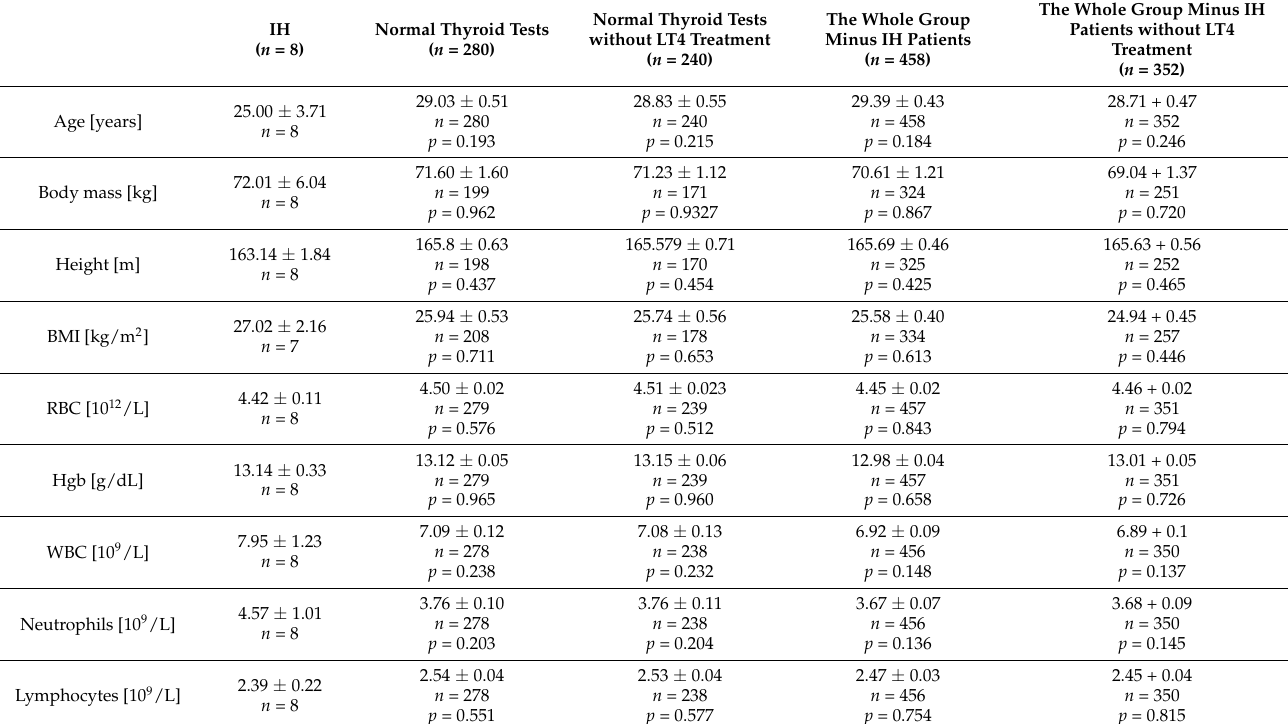
depression When comparing mean values of different linear parameters between patients with IH and patients with normal thyroid tests (also after excluding individuals on L-thyroxine treatment) (Table 2), an obviously significantly lower FT4 concentration was found in the former group. Mean concentration of Vitamin D was lower in females with IH versus patients with normal thyroid tests (also after excluding individuals on L-thyroxine treat- ment); borderline significance was found when comparing to the whole population sample (also after excluding individuals on L-thyroxine treatment). The mean value of IRI was significantly higher in patients with IH compared to all other groups considered. When we applied FDR correction, vitamin D concentration and IRI unfortunately lost this statistical significance, and FT4 concentration expectedly remained statistically significant. Table 2. Clinical/laboratory parameters in patients with isolated hypothyroxinemia (IH) vs. patients with normal thyroid tests (additionally after excluding individuals on L-thyroxine (LT4) treatment) and vs. the whole group of 466 inpatients minus patients with IH (additionally after excluding individuals on L-thyroxine (LT4) treatment). The Whole Group Minus IH Normal Thyroid Tests The Whole Group IH Normal Thyroid Tests Patients without LT4 without LT4 Treatment Minus IH Patients ( n = 8) ( n = 280) Treatment ( n = 240) ( n = 458) ( n =